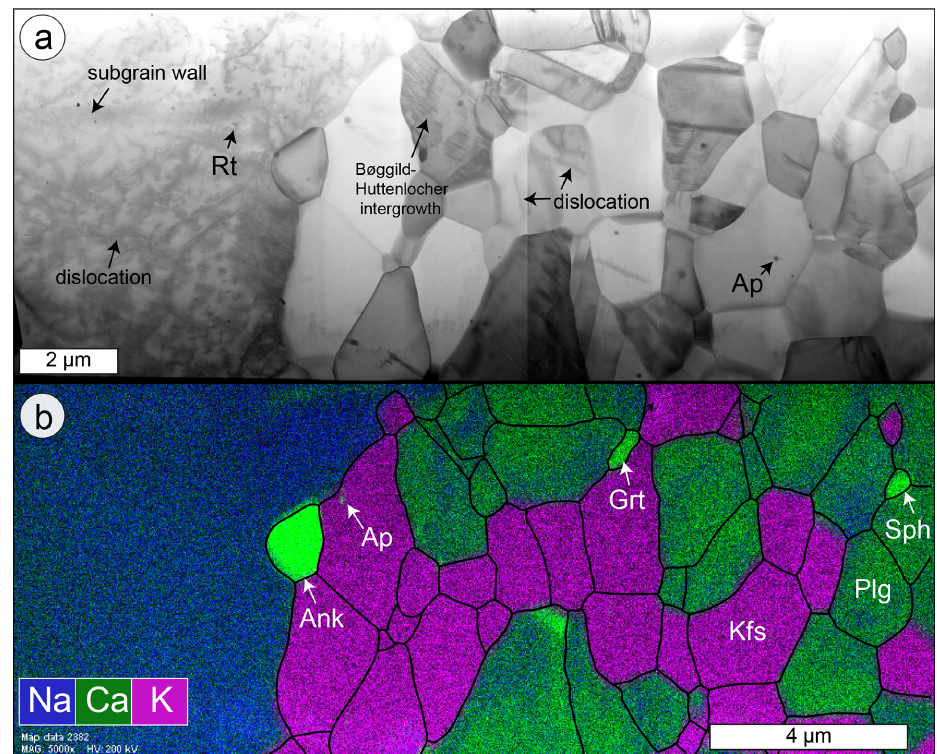
Figure 5. Microstructures of MF1. (a) BF-STEM image of the entire FIB cut from Fig. 1d. The plagioclase (Plg) host to the left is rich in dislocations, whereas the grains within the microfracture to the right are poor to absent with respect to dislocations. Apatite (Ap) and rutile (Rt) inclusions are present within the host and the grains, as well as pinned along grain boundaries in the microfracture. (b) EDX map overlain with grain and phase boundaries (black). Ankerite (Ank), garnet (Grt) and sphene (Sph) are additional phases within the